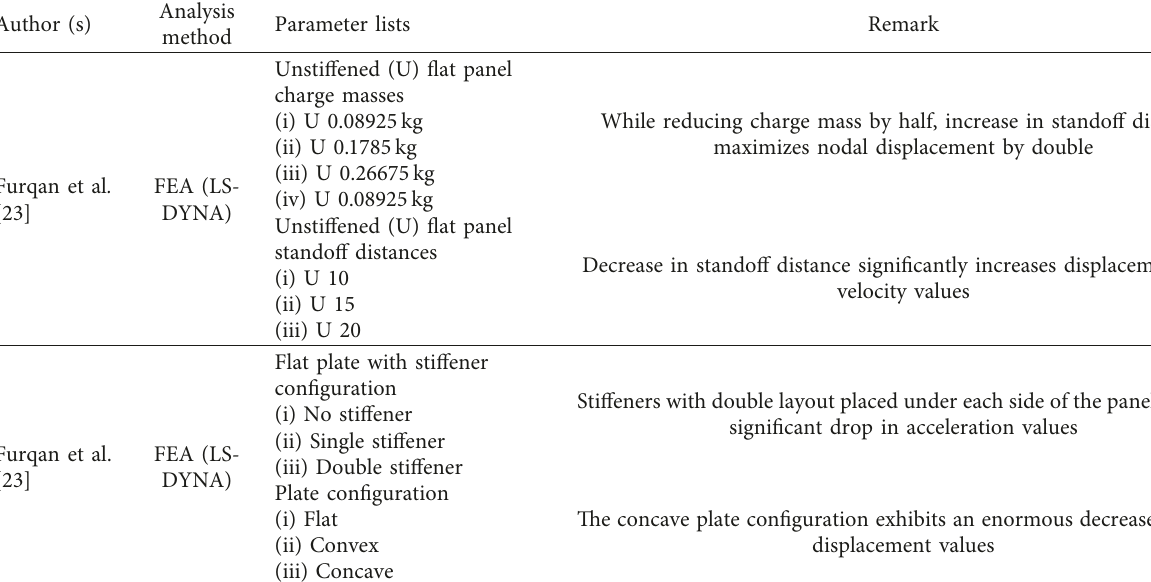
Table 9: Summary of different parameters and respective effects on stiffened and curved panels under blast and impact loads.